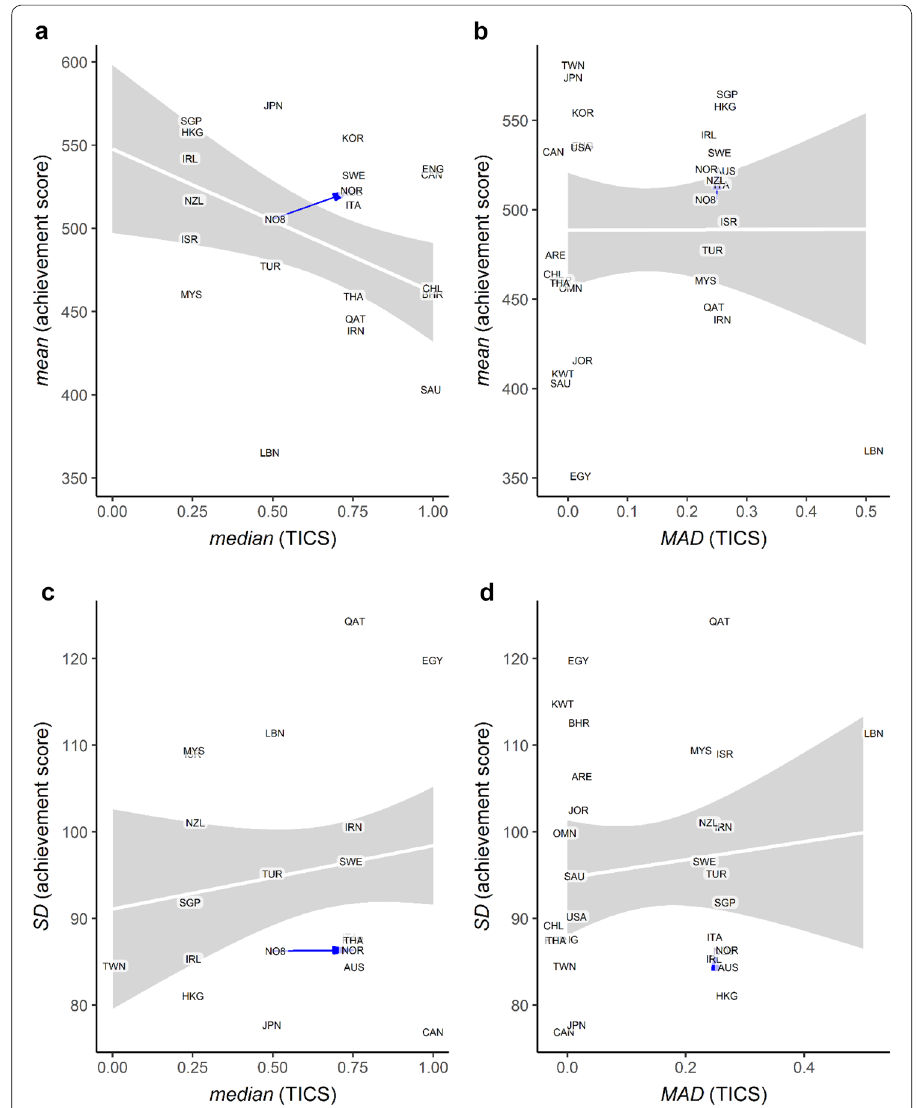
Fig. 8 a – d Scatterplots of between-country relationships in earth science between central tendency (mean achievement and median TICS) and spread (standard deviation of achievement and median absolute deviation of TICS). The white line is the best simple linear fit line, and the gray band is its 95% confidence interval (bootstrapped from 10,000 draws). As there was little between-country variation in median absolute deviation (MAD) of TICS, the x -axis values in b and d were slightly jittered to increase visibility of points. The blue arrow indicates the shift from Norway grade 8 to grade